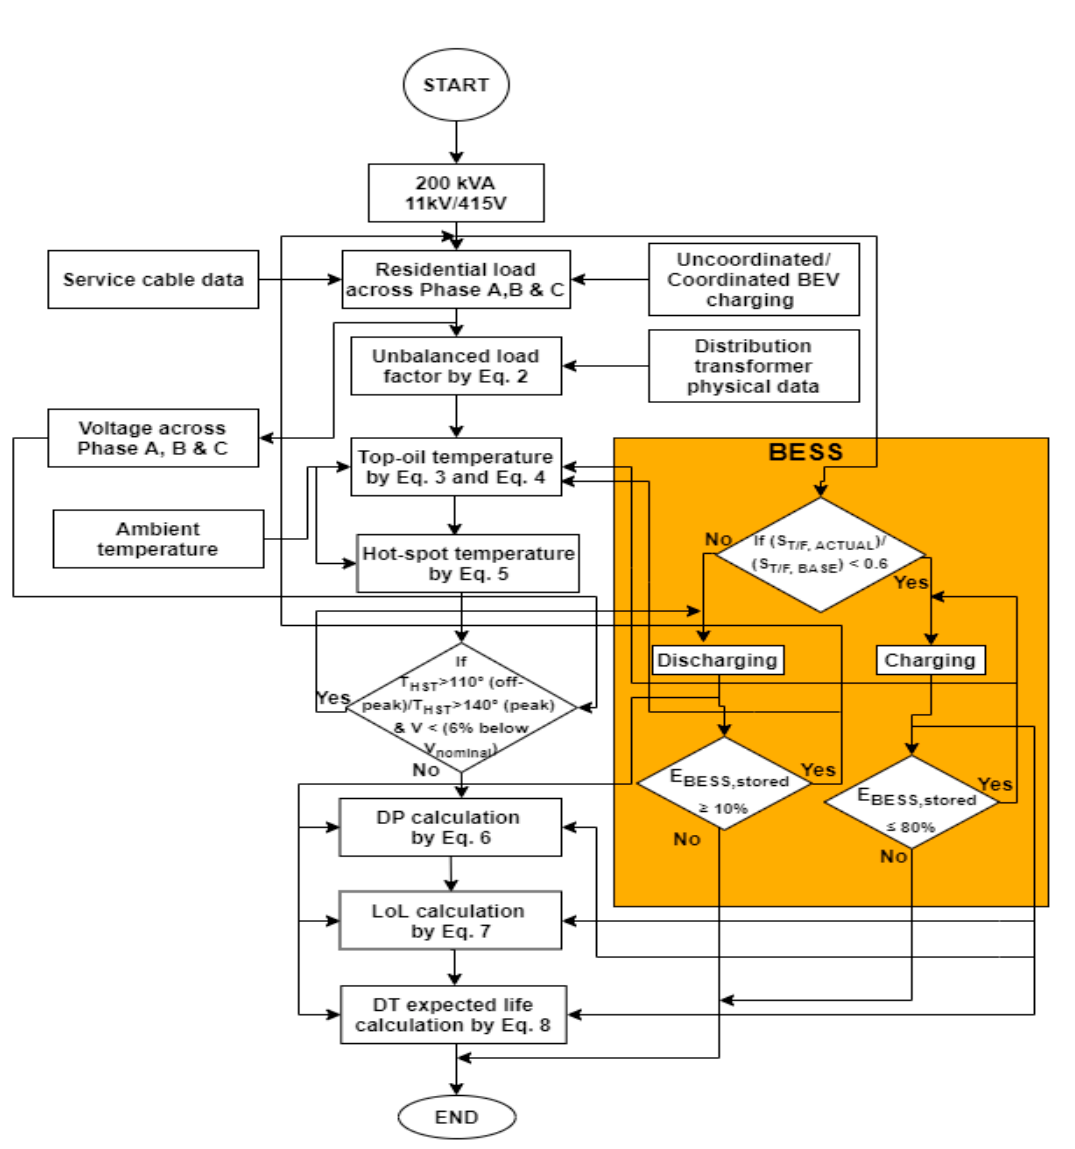
Figure 1. Flow diagram of the proposed dynamic rating operated distribution transformer–battery energy storage system (DRoDT–BESS) technique.